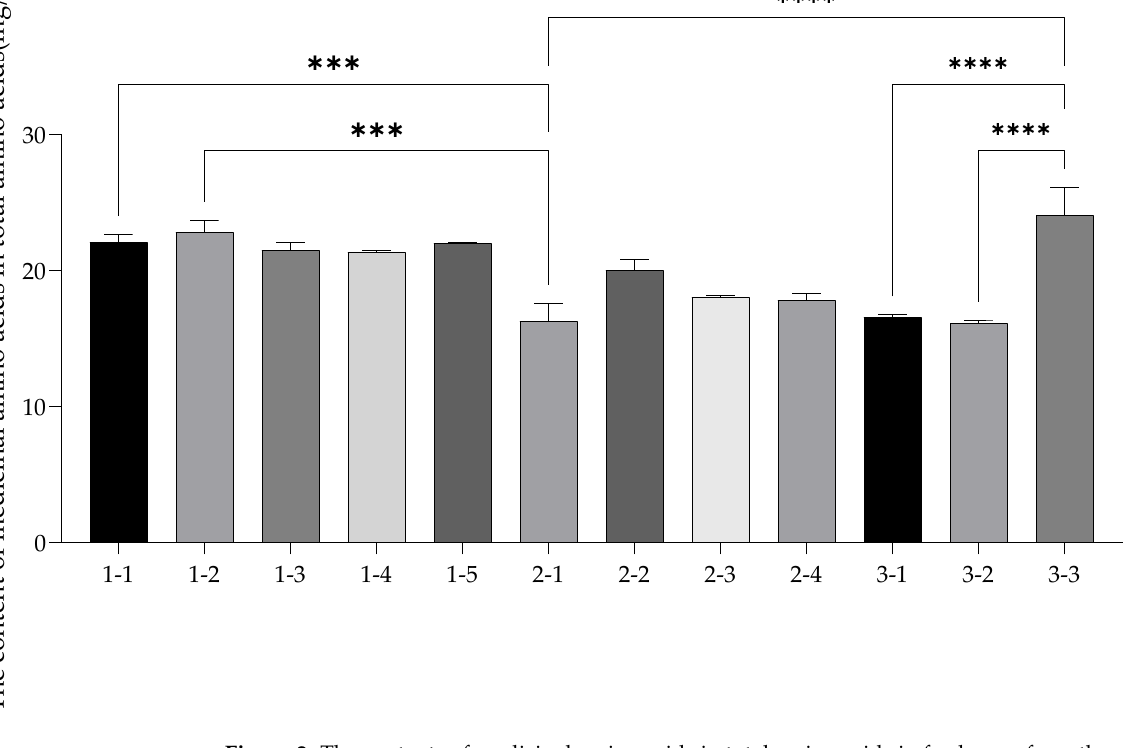
Figure 2. The contents of medicinal amino acids in total amino acids in fresh corn from three regions. The contents of medicine amino acids in fresh corn 3–3 and 2–1, 3–1, and 3–2 had extremely significant differences **** ( p < 0.0001). Due to limited space, the figure only marks the extreme significant differences ( p < 0.0001) and some significant differences ( p < 0.001) among the medicine amino acid content of the samples.